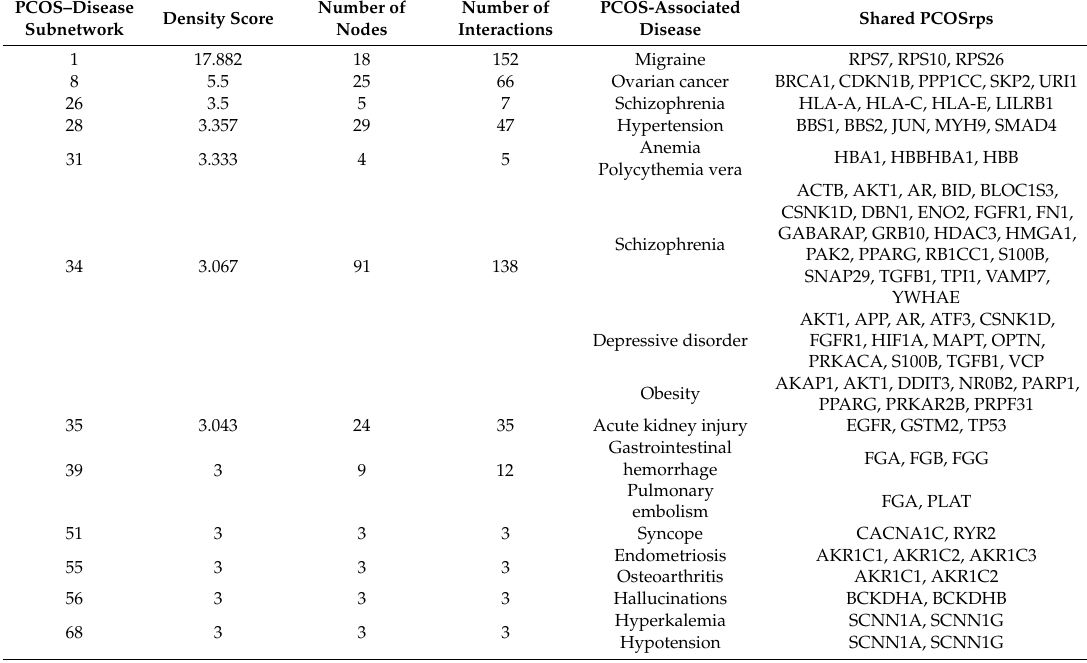
Table 1. Significant PCOS–disease subnetworks. Significant subnetworks with shared PCOSrps, suggesting diseases association with